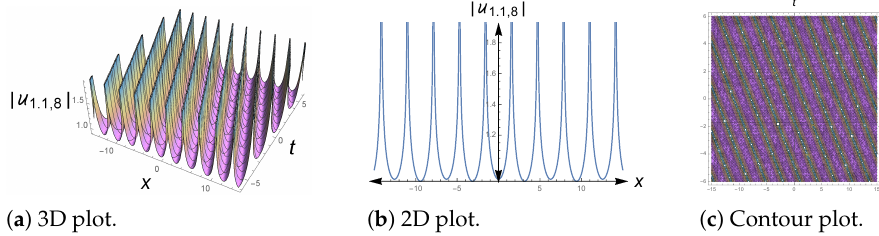
( a ) 3D plot. ( b ) 2D plot. ( c ) Contour plot. Figure 3. Graphical simulation of periodic solutions to Equation (46).